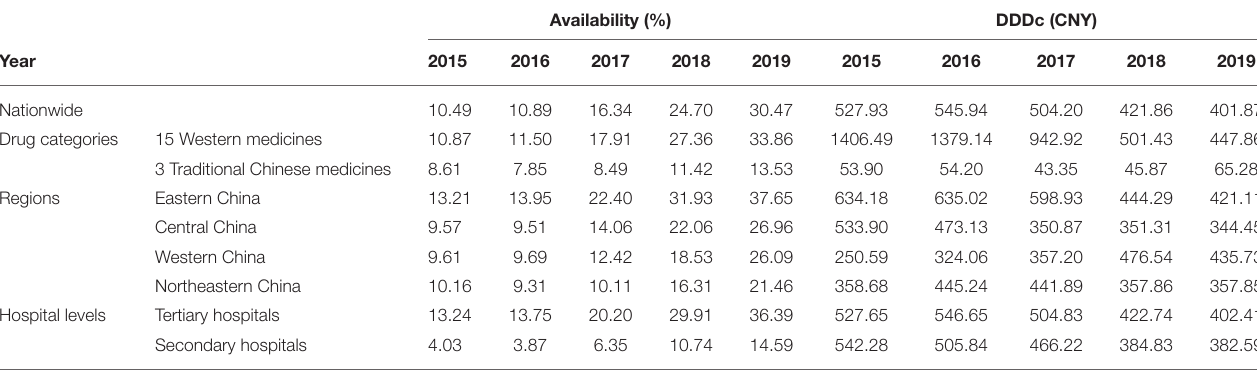
TABLE 2 | Descriptive results of both overall yearly availability and DDDc in the nationwide, regional, hospital-level, and drug category contexts for each observed year (2015–2019).